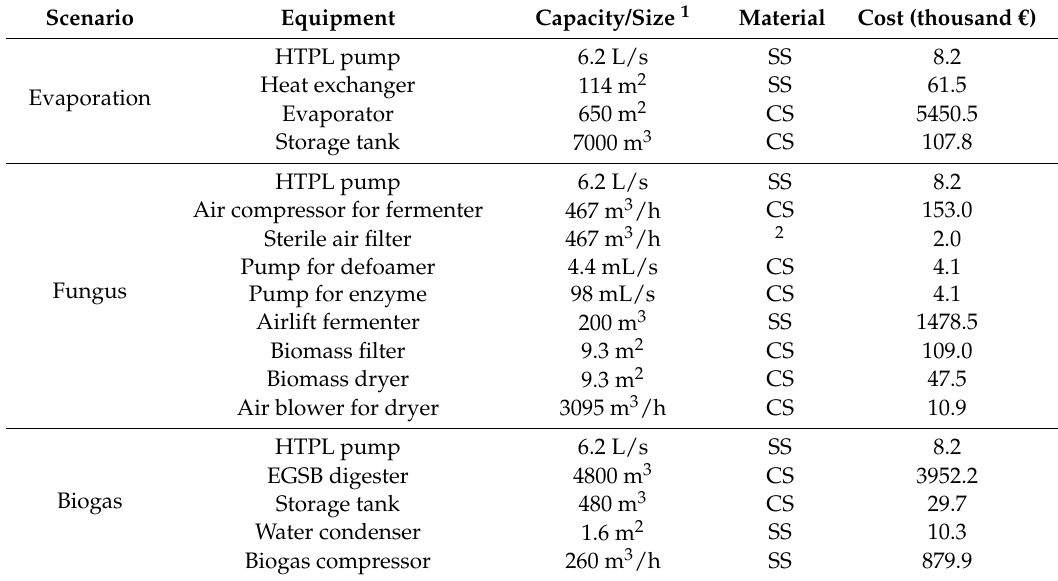
Table 6. Equipment costs for the different